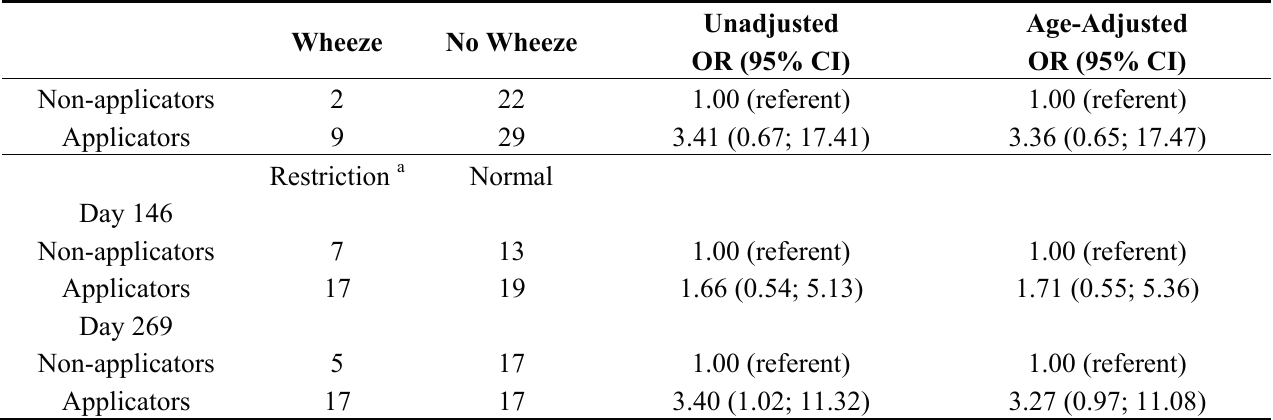
Table 2. Odds ratios and 95% confidence intervals, pesticide applicator status and lung function